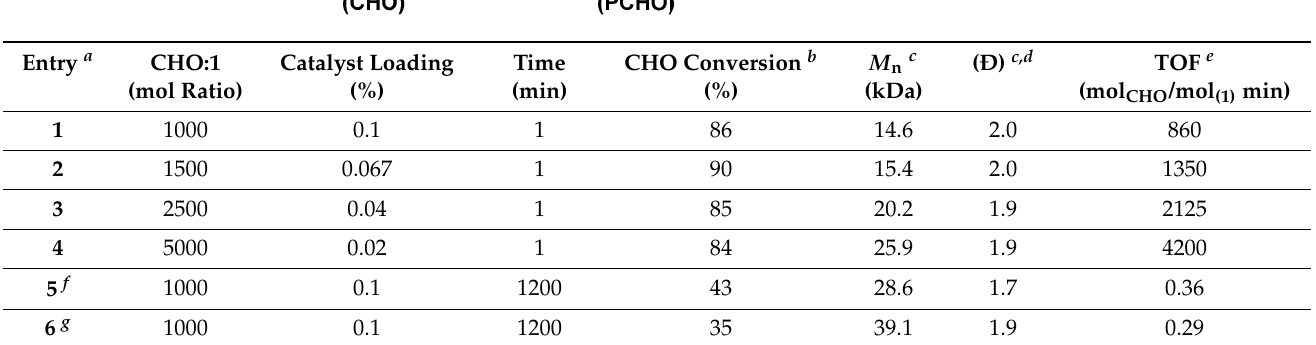
Table 1. Polymerization of neat CHO catalysed by complex 1 .